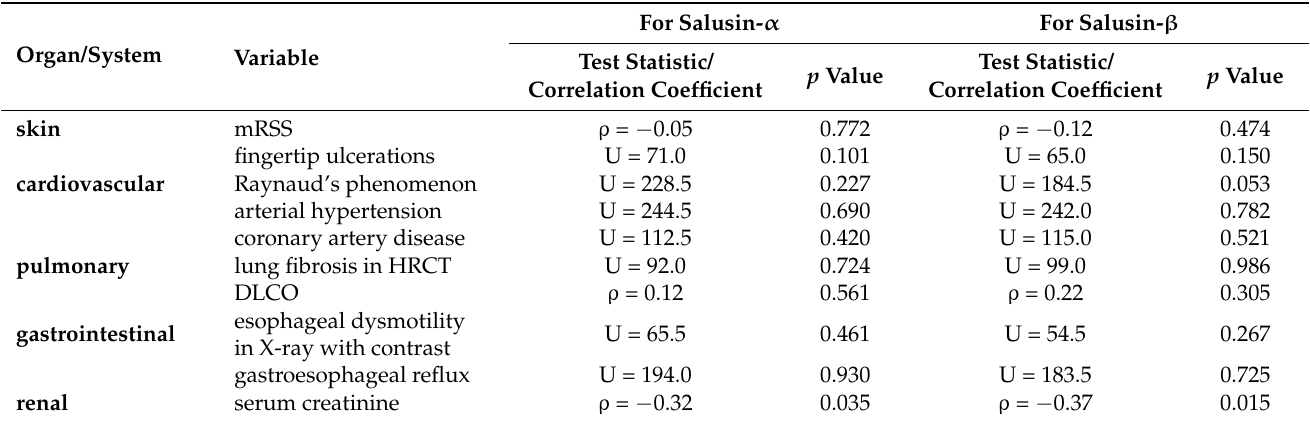
Table 3. Correlations or associations between parameters reflecting skin or internal organ involvement in systemic sclerosis and salusins